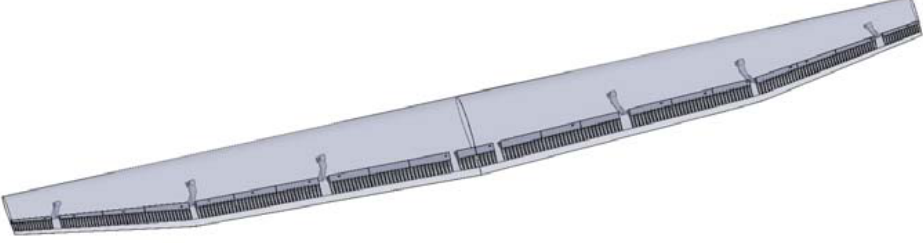
Figure 5. CAD representation of the “comb-like” parts and inner actuation system supports. As for torsional stiffness and controlled twist and camber deformation, the concept relied on the actuation system capability to carry the load and deform the wing sections using a mix of linear and rotational servos distributed along the